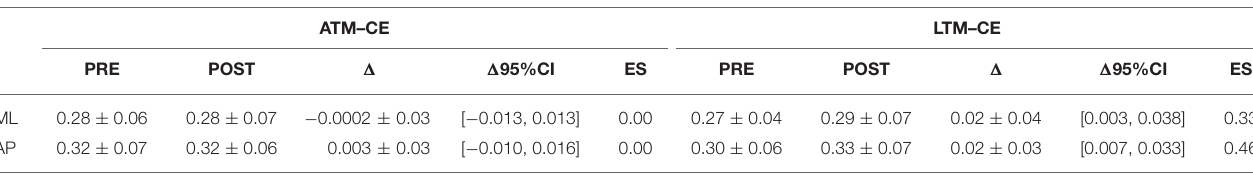
TABLE 6 | Sample entropy results in the CE